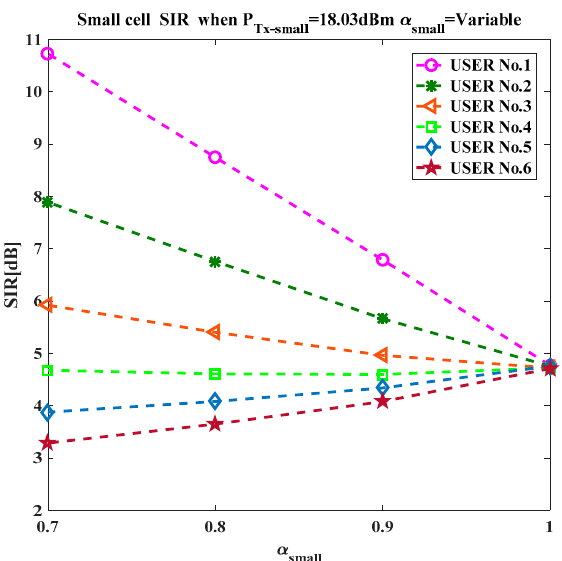
Figure 15. SIR as a function of α small in the HetNet deployment.